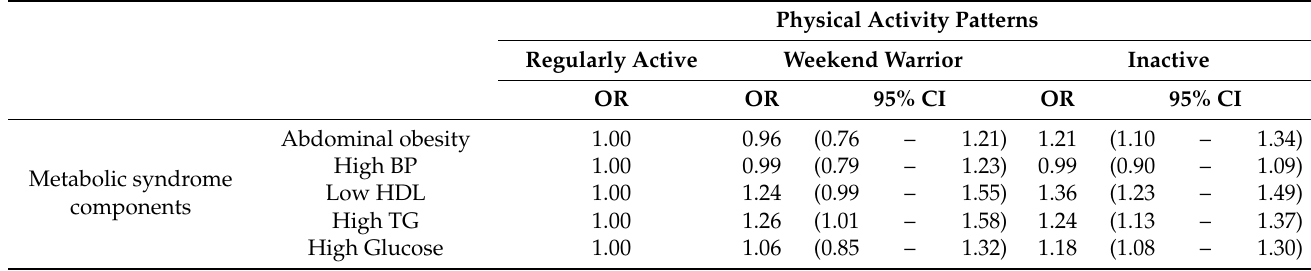
Table 4. Results of subgroup analysis stratified by dependent variables.